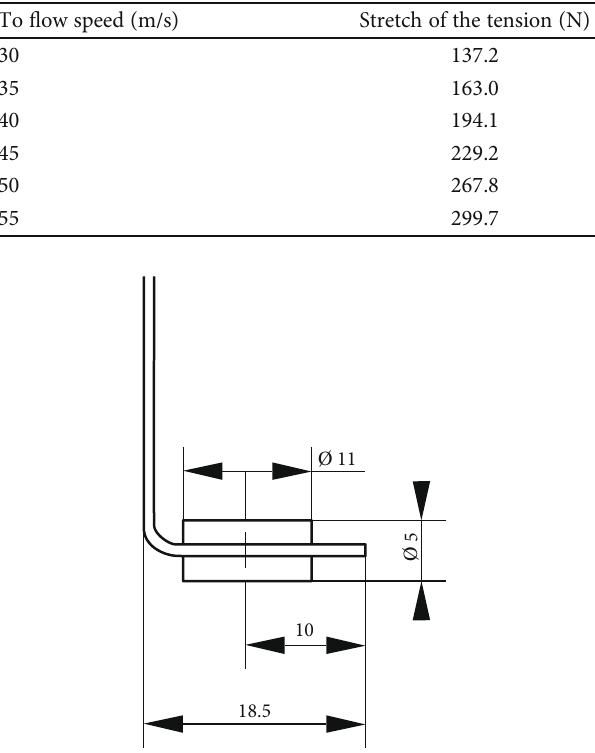
Figure 15: An installation dimension diagram of specimens.